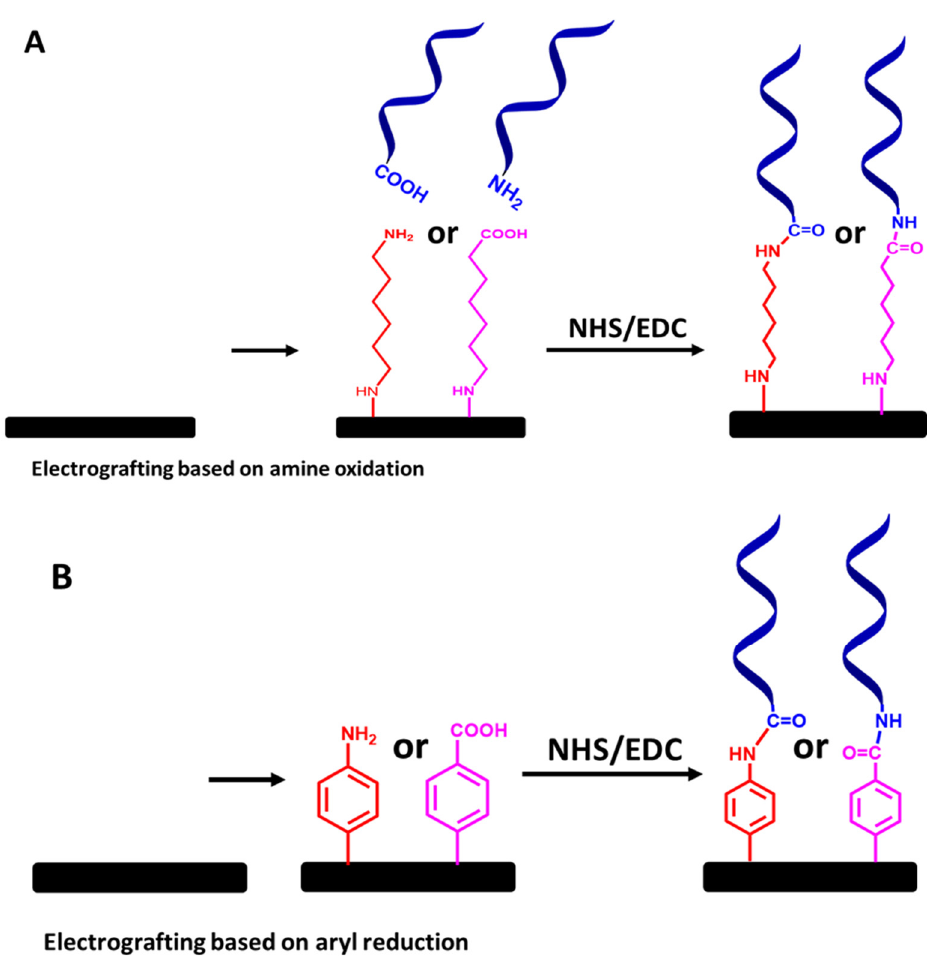
Figure 12. Step-by-step protocols for ssDNA molecular probe attachment using ( A ) electrografted primary amine linkers and ( B ) electrografted diazonium salt linkers, followed by NHS and EDC chemistry. The relative sizes of carbon electrodes, primary amine linkers, diazonium salt linkers, and ssDNA chains are not to